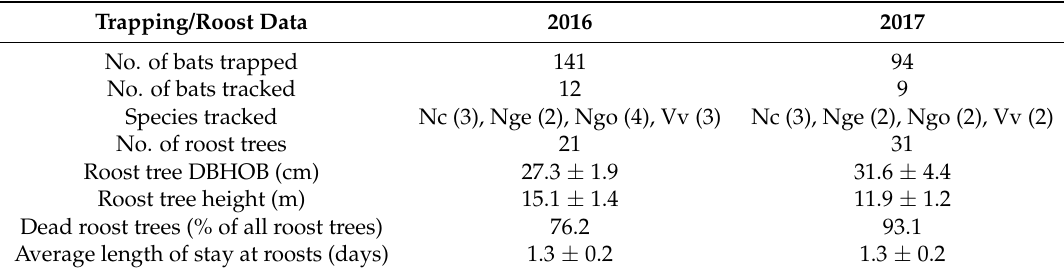
Table 1. Summary of trapping and roost-tree data collected for four species during radio-tracking over two maternity seasons (2016 and 2017). DBHOB, diameter at breast height over bark.